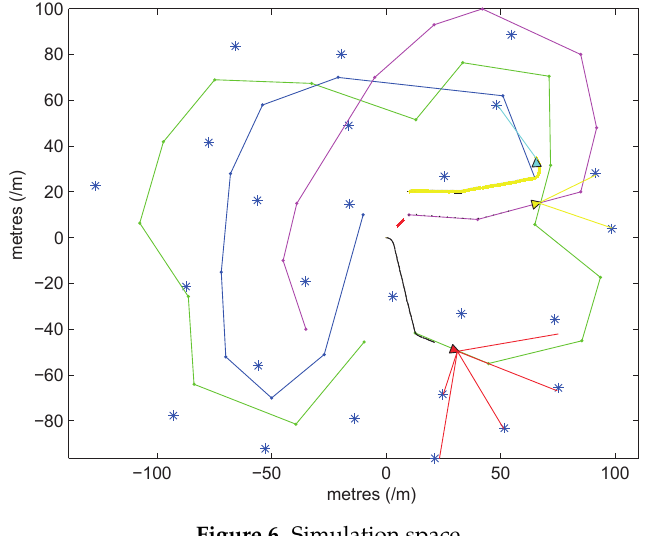
Figure 6. Simulation